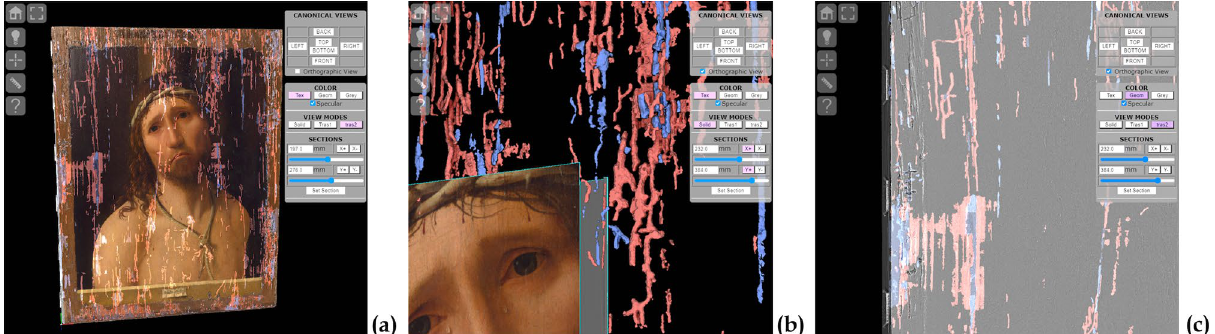
Figure 3. The combined inside and out dataset. ( a ) All the tunnels and anomalies, shown in transparency below the surface. Empty and filled tunnels are shown in red and blue, respectively. ( b ) The networks of different sized tunnels. ( c ) Loss of cohesion between the wood fibres on the left of the